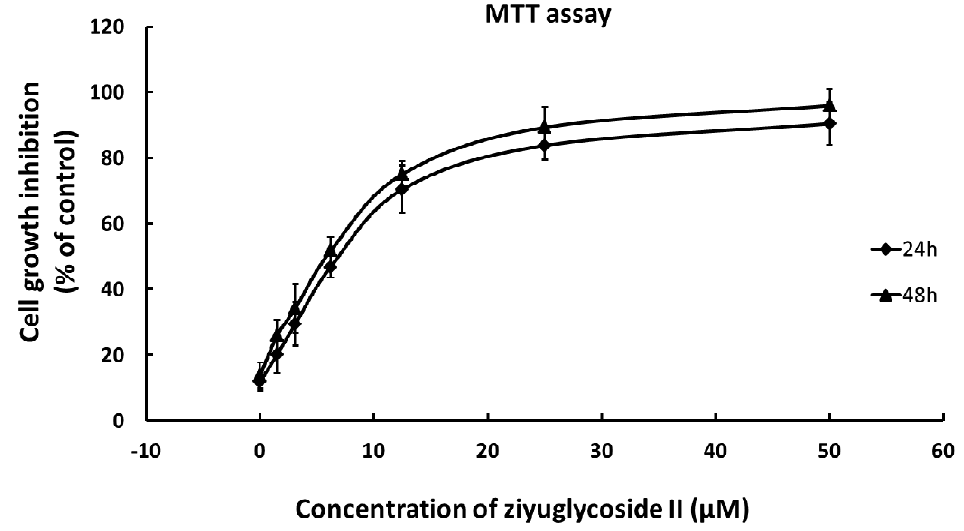
Figure 1. The inhibitory effect of ziyuglycoside II on the cell growth of MDA-MB-435 cells at 24 h and 48 h. All data were expressed as mean ± SD of three experiments and each experiment included triplicate repeats.